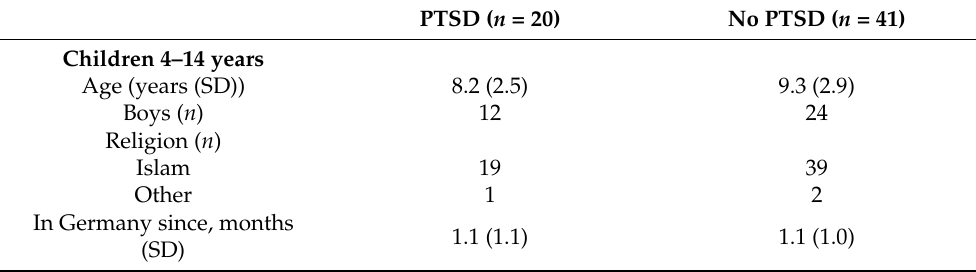
Table 1. General characteristics of the study population.